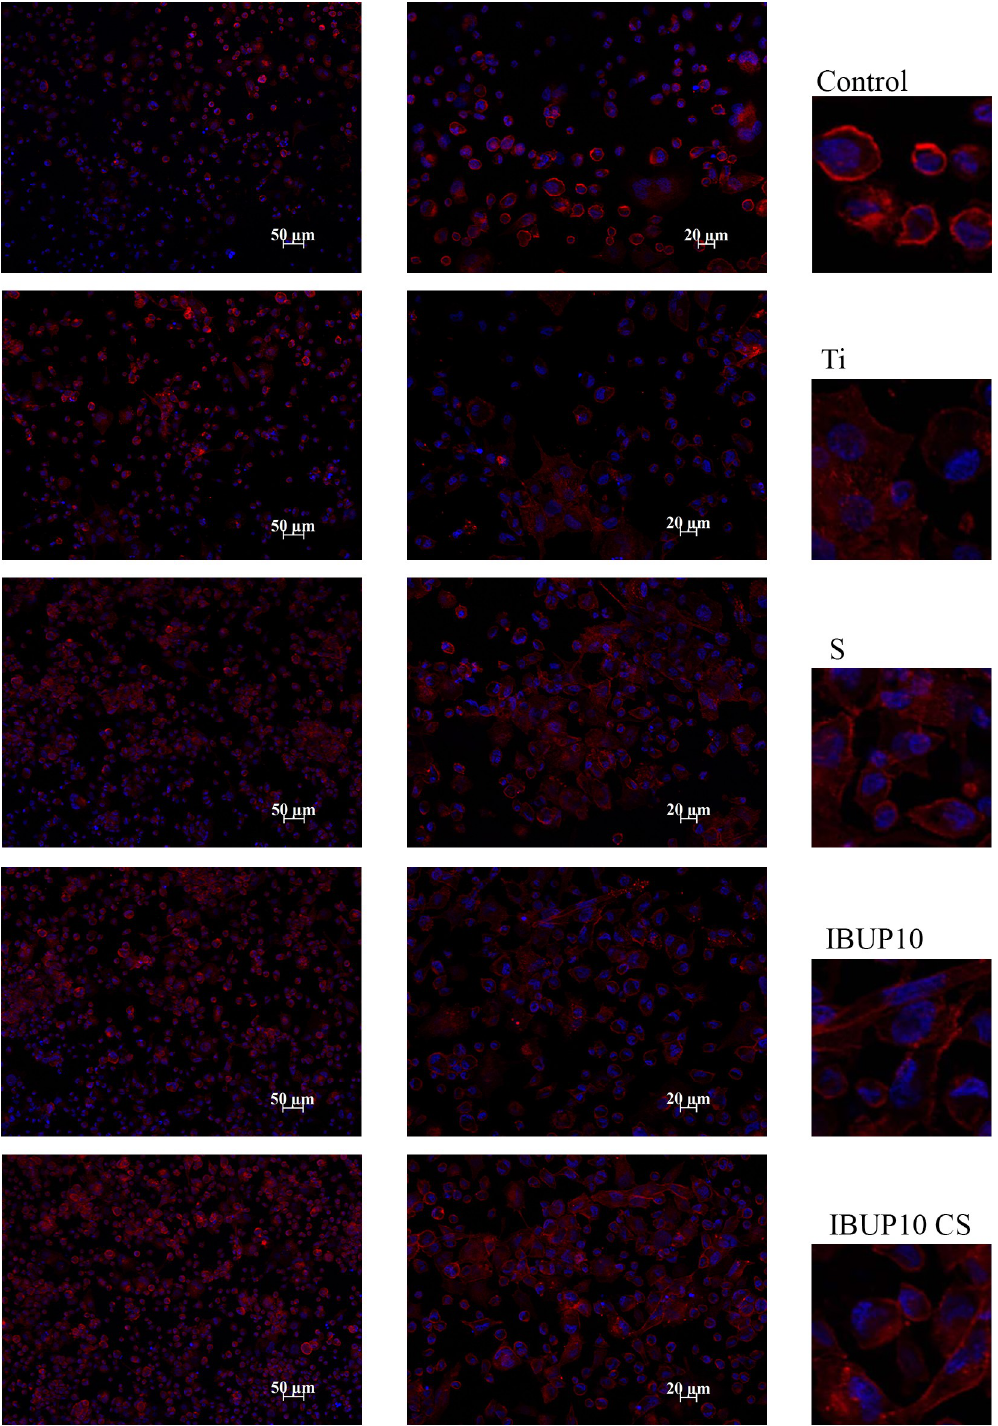
Figure 9. Adhesion and distribution of di ff erentiated THP-1 cells on coatings of composite biopolymeric spheres. Representative images of the attached cells obtained by fluorescence microscopy (40 × ) by marking actin filaments (red) and nuclei